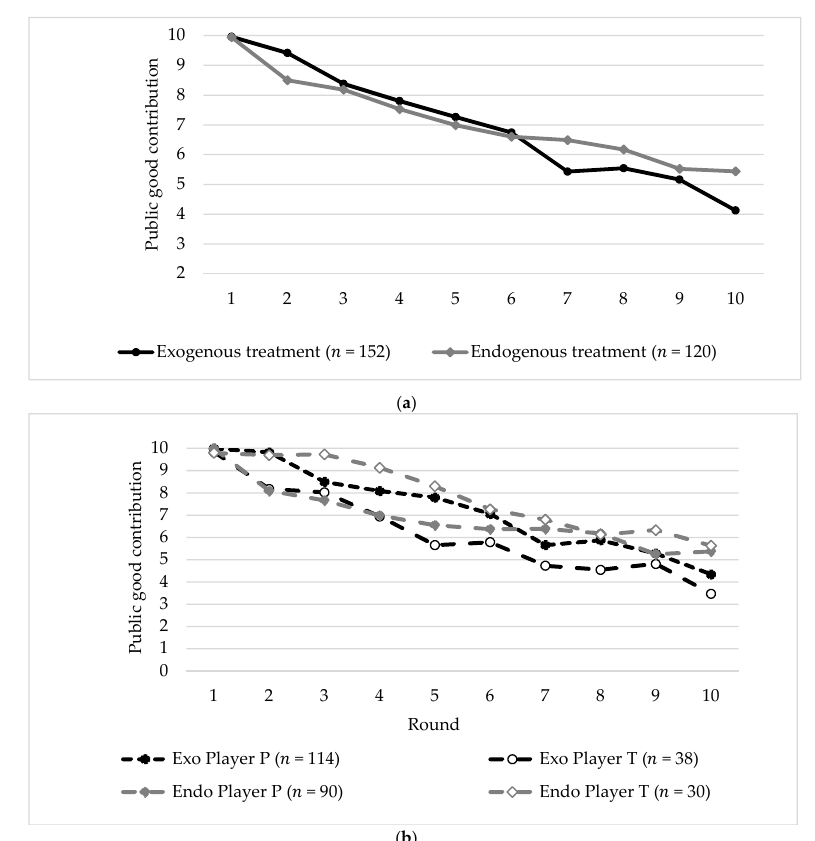
Figure 2. ( a ) Mean contribution over rounds in part I per treatment. ( b ) Mean contribution over rounds in part I per treatment and player type.